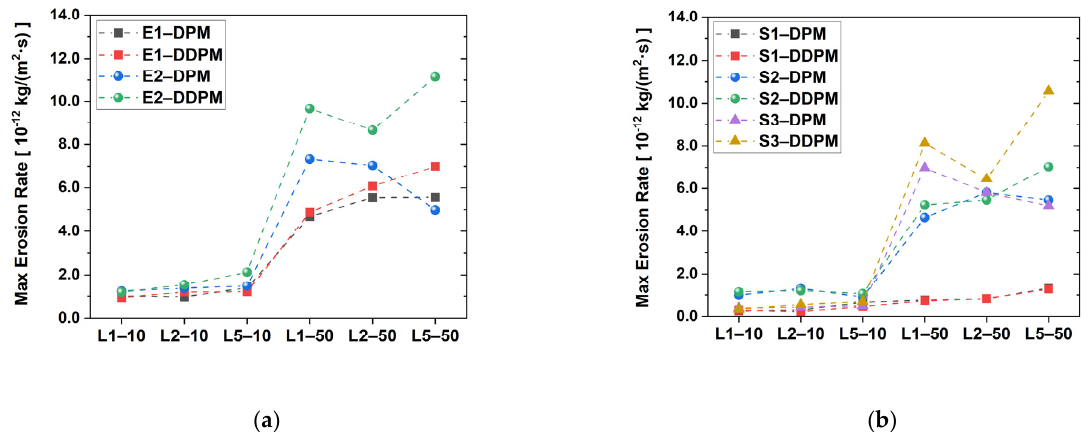
Figure 17. The max erosion rate calculated by the DDPM and the DPM: ( a ) Erosion in the elbows; ( b ) erosion in the straight pipes.